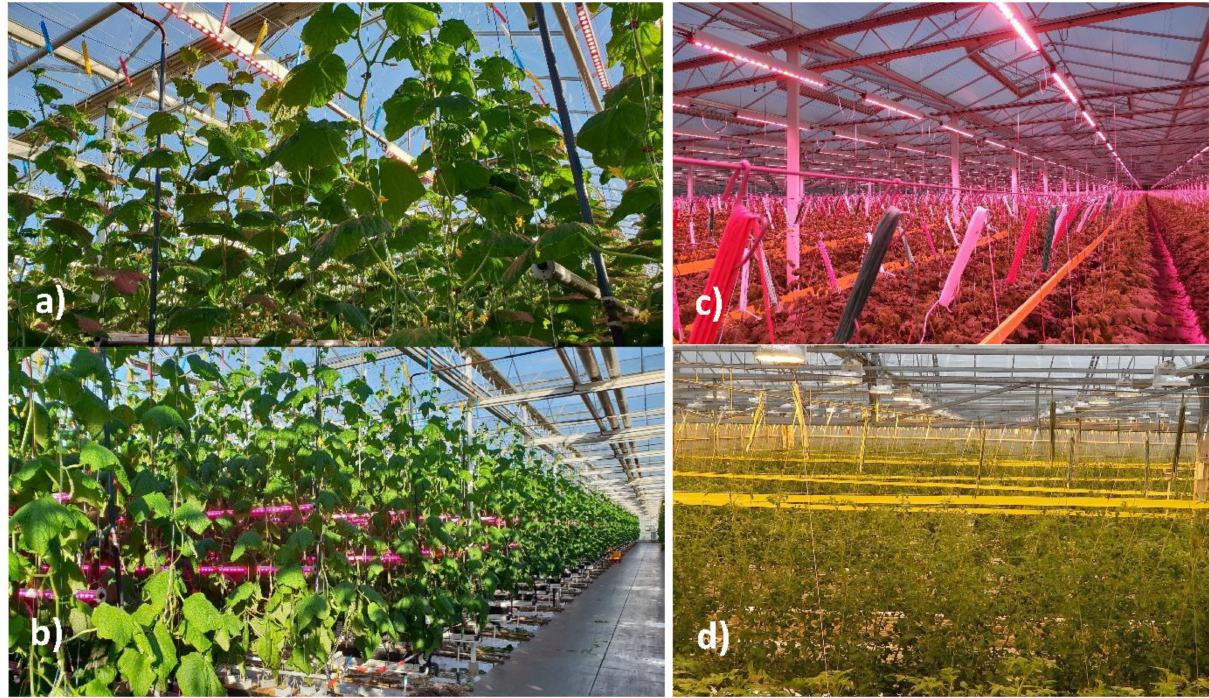
Figure 1. Overhead LED system + intracanopy LED installation ( a ); two lines of intracanopy LED installation as sole SL source ( b ); LED overhead-distributed SL source ( c ); HPS overhead point SL source ( d